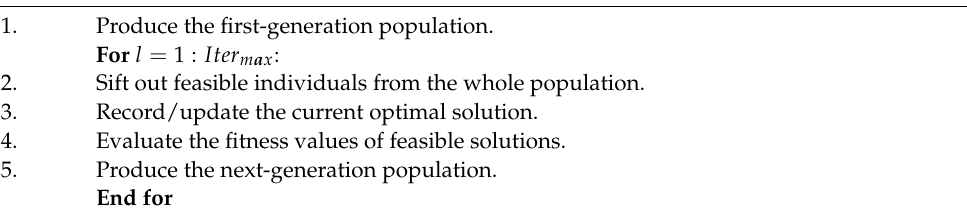
Algorithm 1 General process of the population-based optimization